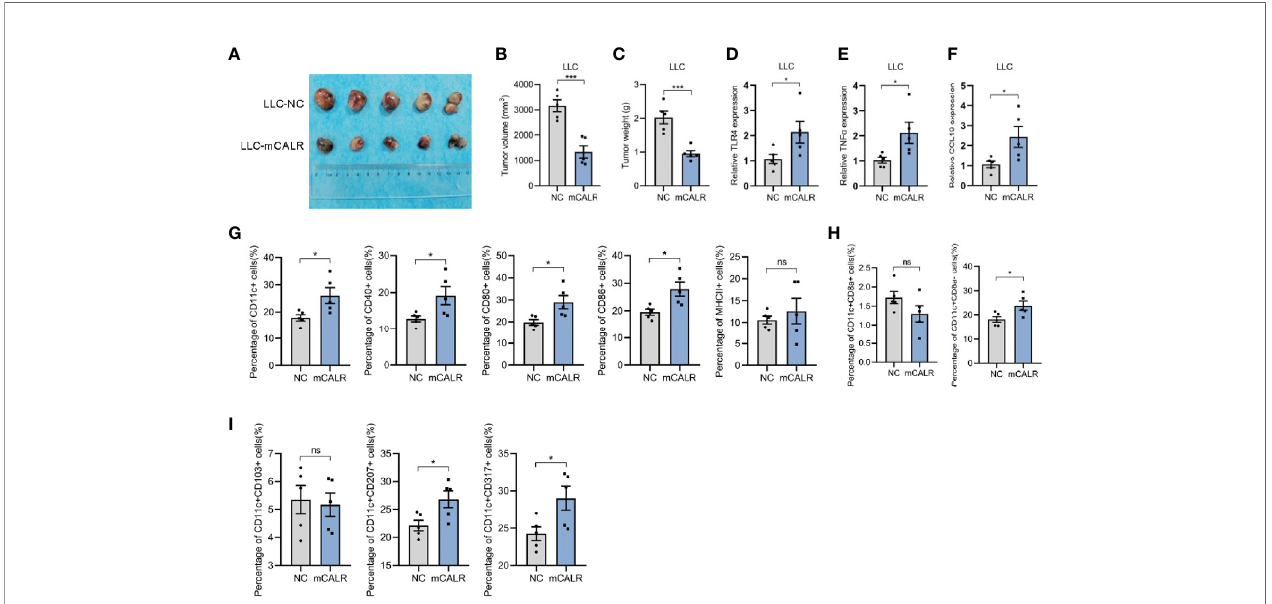
FIGURE 6 | mCALR inhibits lung cancer progression by facilitating DC in fi ltration in tumor tissues. (A) A tumor formation assay was performed by injecting LLC-NC and LLC-mCALR cells, n = 5 mice. (B, C) Quanti fi cation of the volume (B) and weight (C) of tumors generated in mice, *** P < 0.001. (D – F) The relative mRNA expression levels of TLR4, TNF a , and CCL19 were detected in tumors of LLC-NC and LLC-mCALR groups using real-time PCR; * P < 0.05. (G) The relative percentages of CD11c+, CD40 +, CD80+, CD86+, and MHCII+ DCs in tumors were detected using fl ow cytometry; ns, P > 0.05, * P < 0.05. (H) The relative percentages of CD11c+CD8a+ and CD11c +CD8a- DCs in tumors were detected using fl ow cytometry; ns, P > 0.05, * P < 0.05. (I) The relative percentages of CD11c+CD103+, CD11c+CD207+, and CD11c +CD317+ DCs in tumors were detected using fl ow cytometry; ns, P > 0.05, * P <